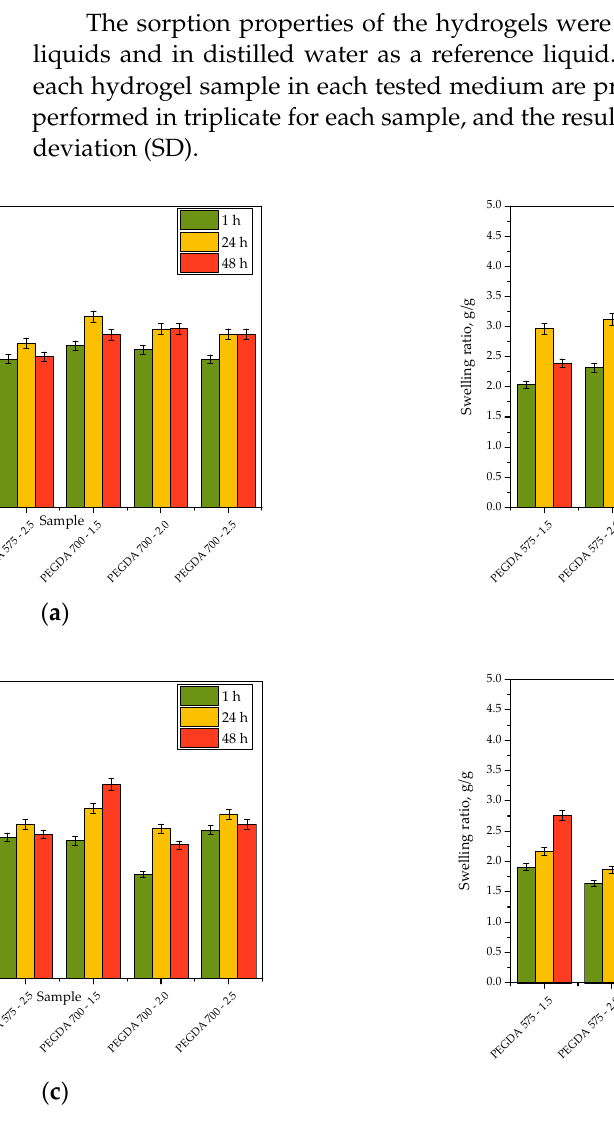
Figure 9. Swelling ability of hydrogels in distilled water ( a ), SBF ( b ), Ringer solution ( c ), and hemoglobin ( d ).